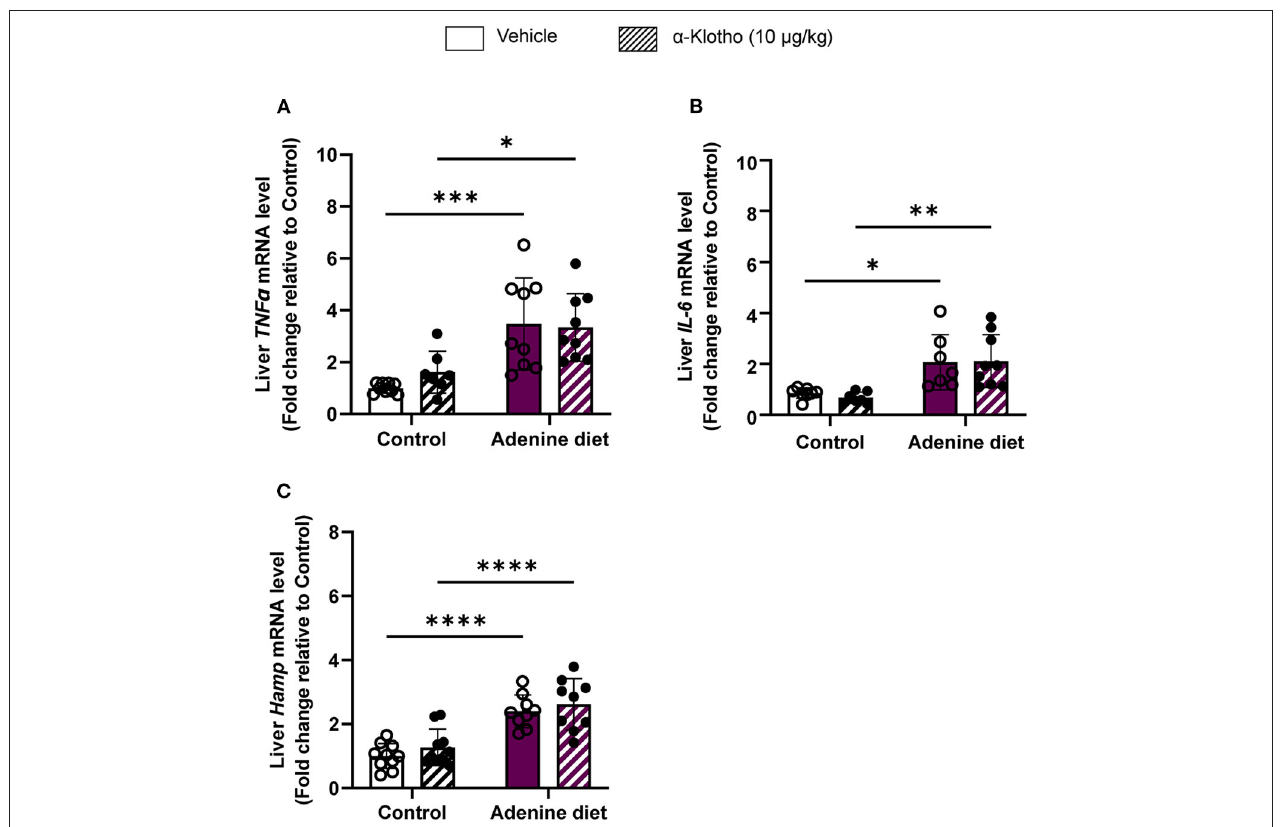
FIGURE 4 | Effect of Klotho administration on inflammation in CKD. C57BL/6J male mice were fed control diet or 0.2% adenine diet. After 8 weeks, mice in each group were further divided into 2 groups and were injected with either saline or mouse recombinant Klotho protein (10 µ g/kg) 24h prior to sacrifice. Liver tissue samples were collected at the end of the experiment and relative mRNA expression was determined by quantitative real-time RT-PCR for (A) TNF α , (B) IL-6 , and (C) hepcidin (Hamp) . Data are represented as mean ± SD ( n = 7–10 per group). * P < 0.05, ** P < 0.01, *** P < 0.001, **** P < 0.0001 compared to